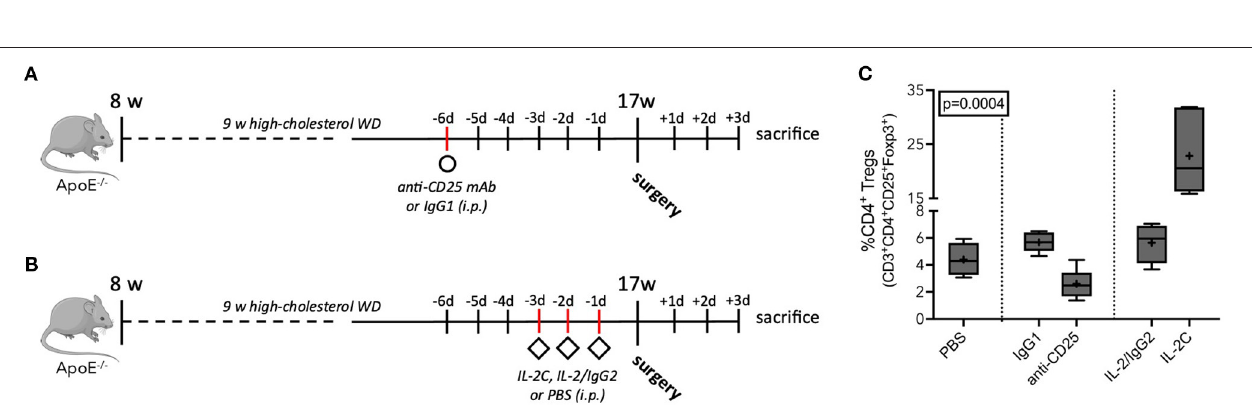
FIGURE 2 | Antibody-mediated Treg modulation in atherosclerotic ApoE − / − mice. (A) Schematic of preoperative anti-CD25-mediated Treg downregulation and (B) IL-2 complex (IL-2C)-induced expansion of Tregs. ApoE − / − mice of mixed gender fed a Western diet (WD) for 9 weeks, underwent the surgical stress model or sham intervention at the age of 17 weeks, and were sacrificed at postoperative day 3. Treg reduction and expansion was induced by a single injection of anti-CD25 mAb (250 µ g per mouse) and three daily injections of IL-2C (complex of 1 µ g recombinant IL-2 plus 5 µ g anti-IL-2 mAb per mouse), respectively. Isotype-matched antibodies and PBS were used as controls. (C) Flow cytometric analysis of circulating CD3 + CD4 + CD25 + Foxp3 + Tregs relative to the CD4 + T cell population at the day of surgery ( n = 4–6). Kruskal-Wallis-test was used to assess statistical difference between the five treatment groups.